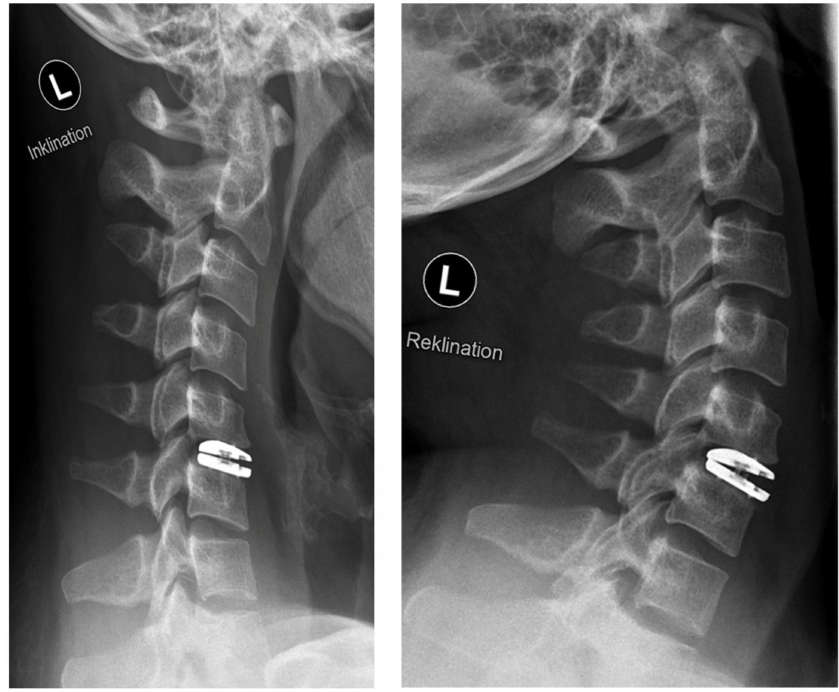
Figure 3. Postoperative radiographs in flexion (“Inklination”) and extension (“Reklination”). A standard anterolateral approach was used in all cases. Prior to incision, the level was marked using fluoroscopy. Discectomy and decompression were performed using a microscope. During surgery, the segment was distracted using screws and a retractor.